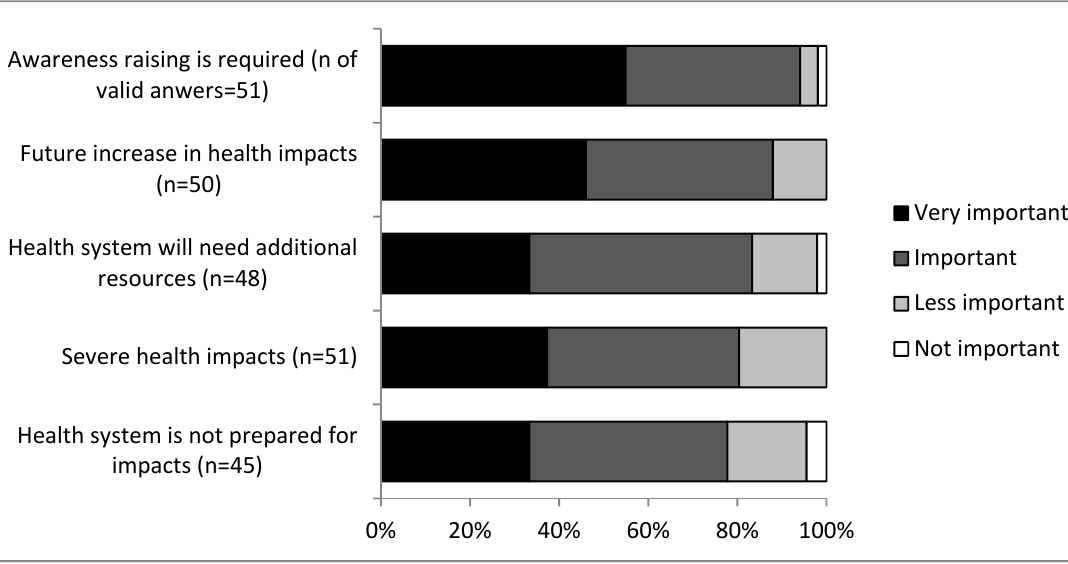
Figure 2. Level of importance of challenges caused by alien species to the Austrian health system as reported by stakeholders (n values refer to valid answers of stakeholders that chose one of the four Likert scale categories).